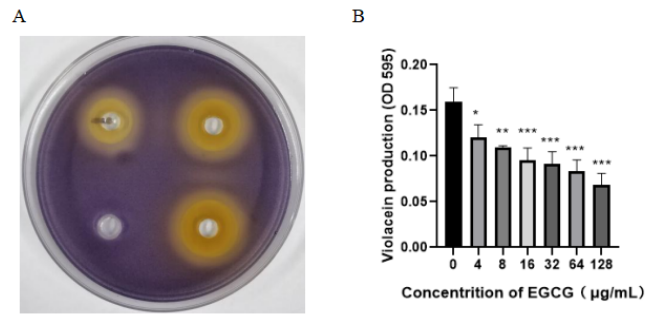
Figure 1. QSI effect of EGCG on biosensor C. violaceum 12472. ( A ) Visual qualitative assay for inhibi- tion of C. violaceum violacein. ( B ) Quantitative estimation of violacein. (All data are representative of three independent experiments performed in triplicate and expressed as the mean ± SD values in each bar. * p < 0.05; * * p < 0.01; *** p <